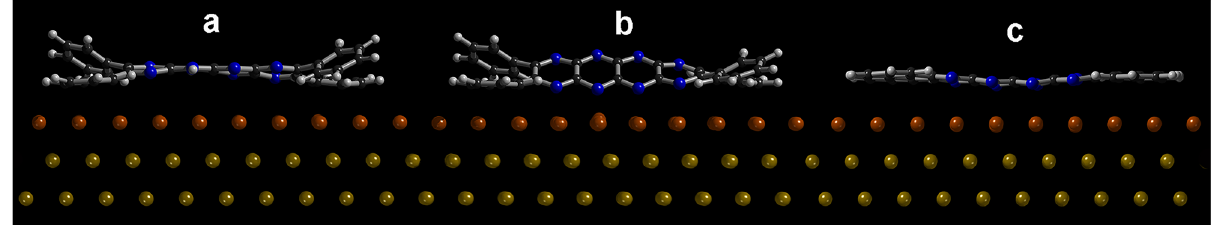
Fig. 4 DFT calculated structures of 2, 2-ox and 2-ox 2 . a Lateral view of the native molecule 2 ; diagonally-opposing phenyl rings and the main body of the molecule are oriented parallel to the surface. b Lateral view of the molecule which forms lines 2-ox ; pyrazinacene backbone undergoes a torsional twist enabling N atoms at one side of the acene body to interact with the Cu(111) surface. Diagonally opposed phenyl rings again interact with the surface. c Lateral view of the cyclodehydrogenated molecule ( 2 -ox 2 ). The fully oxidized compound lies essentially fl at with the shortest distance between molecule and surface compared to the other compounds as is also con fi rmed by the STM pro fi le analysis and DFT-simulated STM images shown in Supplementary